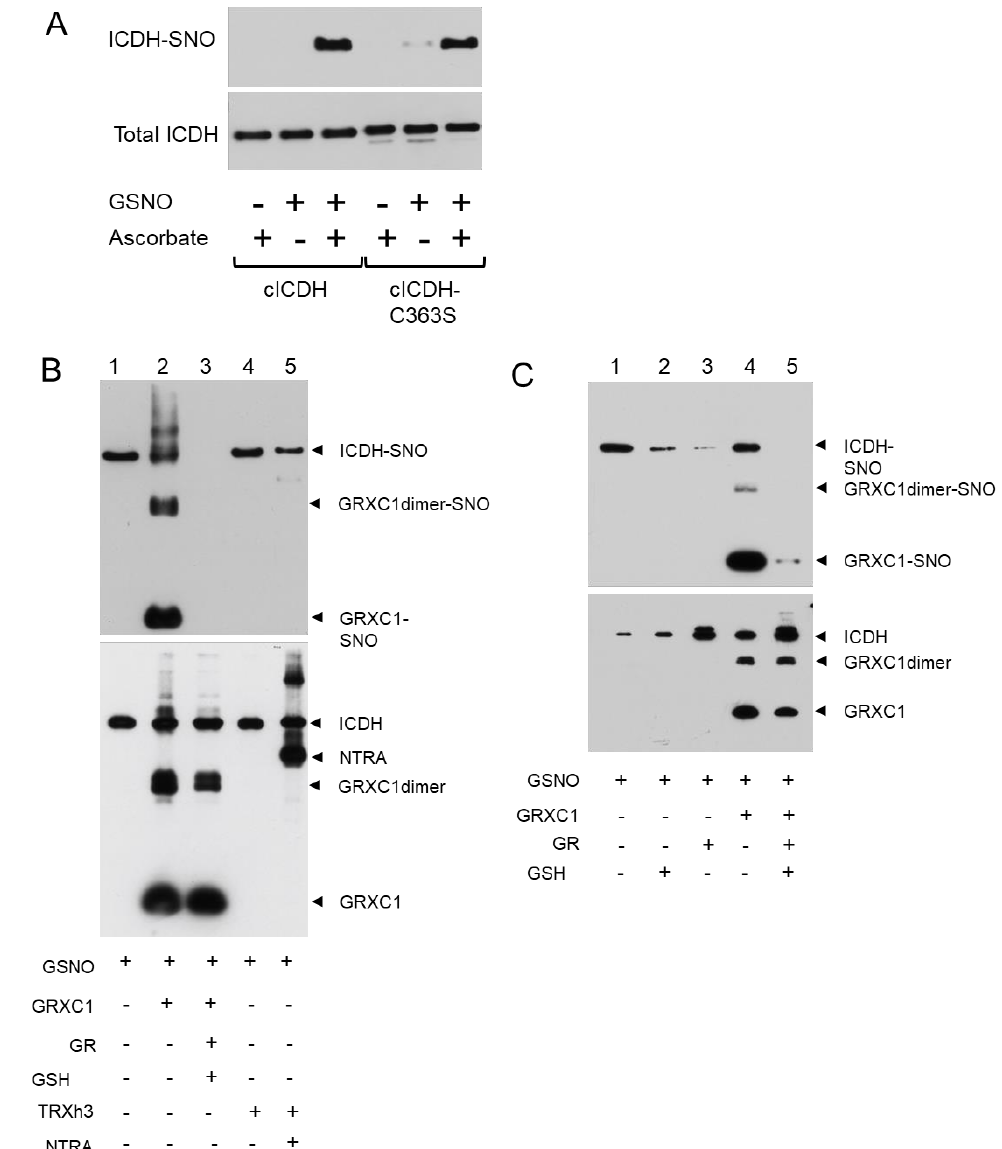
Figure 4. cICDH is S-nitrosylated and is denitrosylated by the GRX system. ( A ) 2.19 µ M of recombinant wild-type cICDH or Cys-mutated versions of cICDH (cICDH-C363S) were treated with or without 1 mM GSNO for 30 min at 25 ◦ C, and subjected to the biotin-switch assay in presence or absence of sodium ascorbate. ( B ) After treatment with GSNO (1 mM), the protein was treated with GRXC1 (5 µ M) alone (lane 2), GRXC1, GSH (0.8 mM) and GR (0.45 µ M) (Lane 3), NTRA (3 µ M) alone (lane 4) and NTRA+TRXh3 (4.59 µ M) (lane 5) for 30 min at 25 ◦ C and subjected to the biotin-switch assay in the presence of sodium ascorbate. ( C ) The same experimental design in the presence of GSH (0.8 mM) (lane 2), GR (5 µ M) (lane 3), GrxC1 (5 µ M) (lane 4) and GRXC1+GR+GSH (lane 5). Afterwards, the proteins were separated by reducing SDS-PAGE and transferred onto nitrocellulose membrane. Total ICDH (bottom panel) or S-nitrosylated ICDH (top panel) was detected using an anti-His